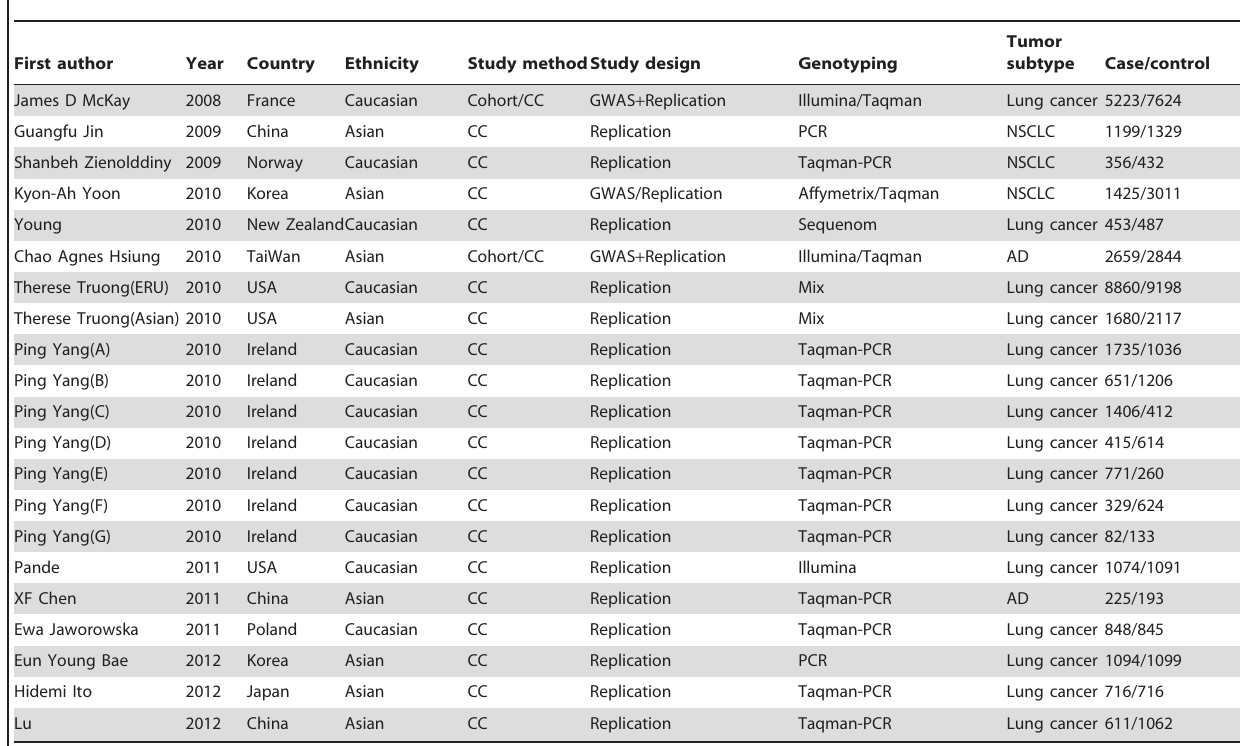
Table 3. Characteristics of studies on rs402710 polymorphisms and risk of lung cancer included in the